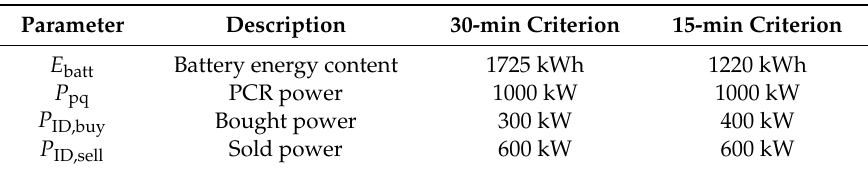
Table 8. Parameters for validation